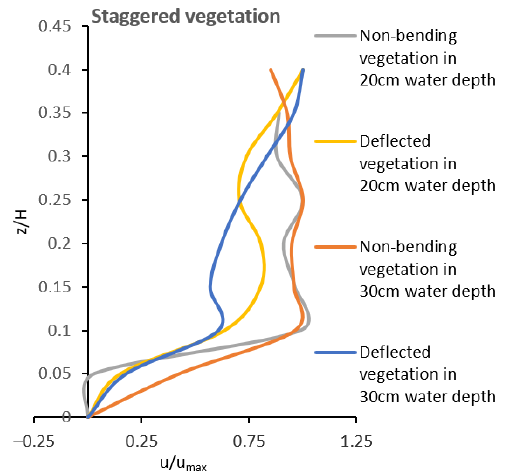
Figure 10. Velocity profiles in the wake zone behind non-bending vegetation elements and deflected vegetation elements, arranged in the staggered configuration in flow with the depths of 20 cm and 30 cm.